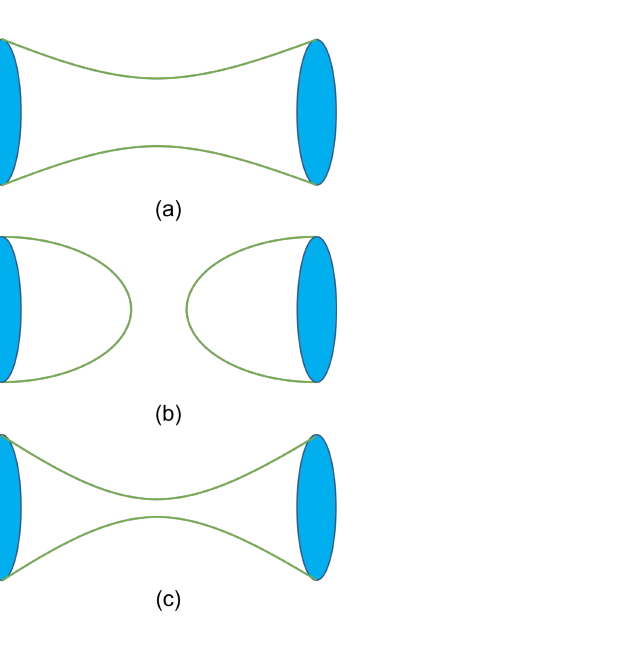
Figure 2 . (a) Stable wormhole phase in the low temperature; (b) two black hole phase in the high temperature; (c) unstable wormhole phase in the low temperature. Note that these pictorial representations are in the euclidean signature.